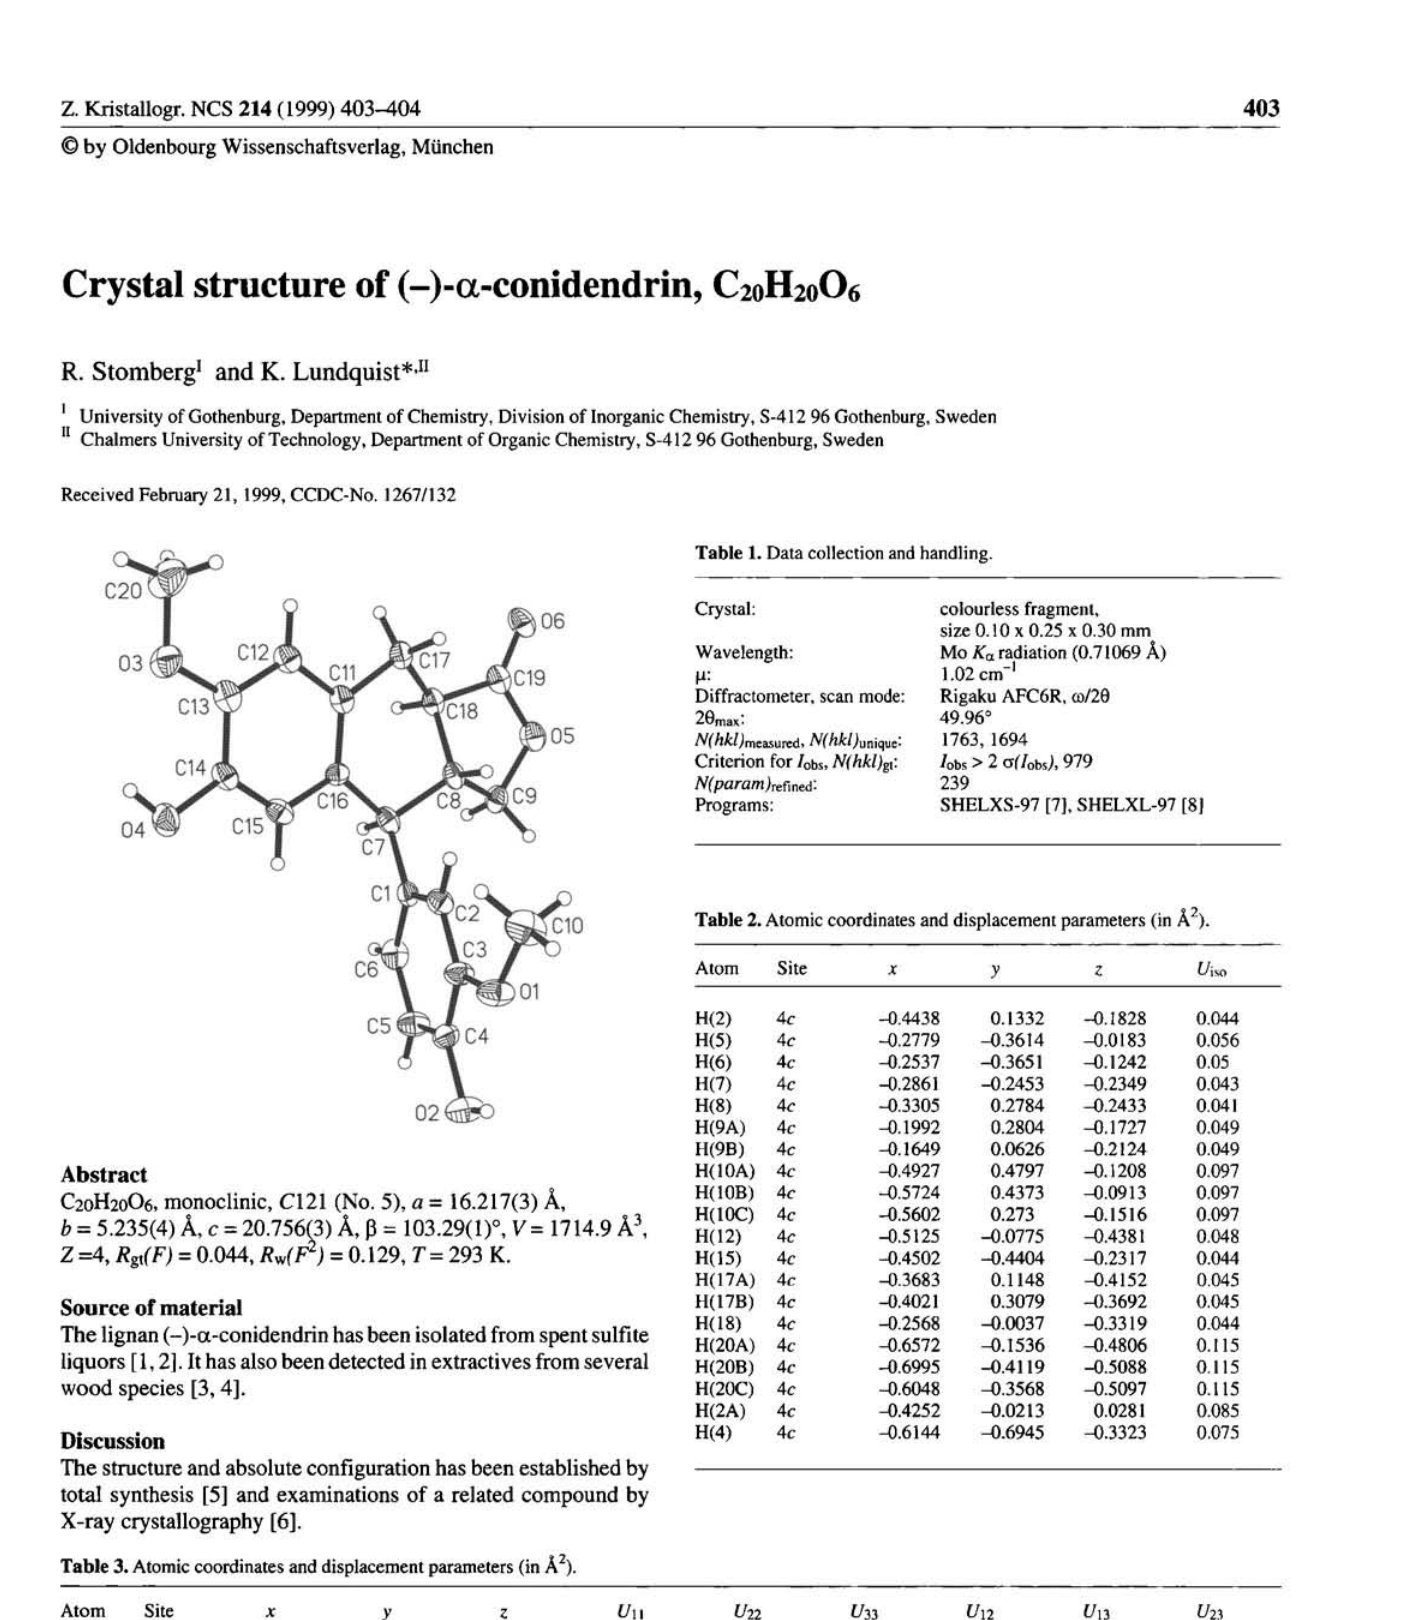
Table 3. Atomic coordinates and displacement parameters (in Â 2 ).